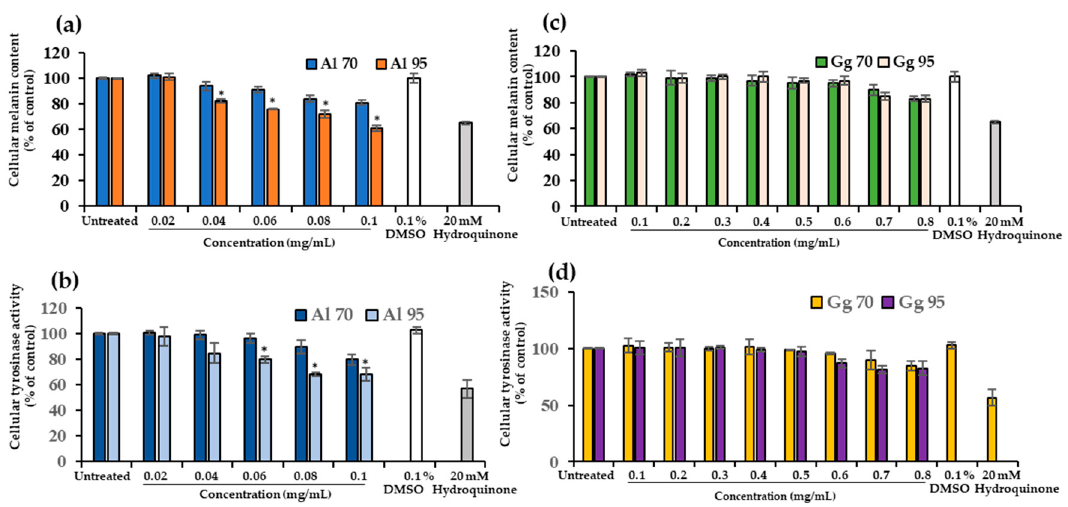
Figure 2. Viability of B16 cells exposed to A. lakoocha and G. glabra extracts. ( a ) A. lakoocha macerated in 70% (Al70) and 95% (Al95) of ethanol; and ( b ) G. glabra macerated in 70% (Gg70) and 95% (Gg95) of ethanol. Percentages of cell viability means ± SD from three independent experiments.